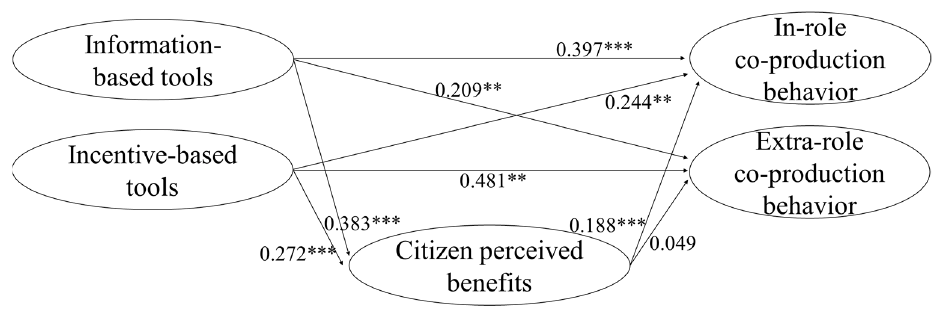
Figure 2. Results of path coefficients. Note: ** represents p < 0.01; *** represents p < 0.001.